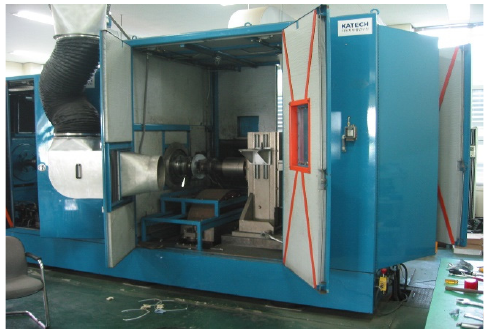
Figure 5. Configuration of brake dynamometer test.